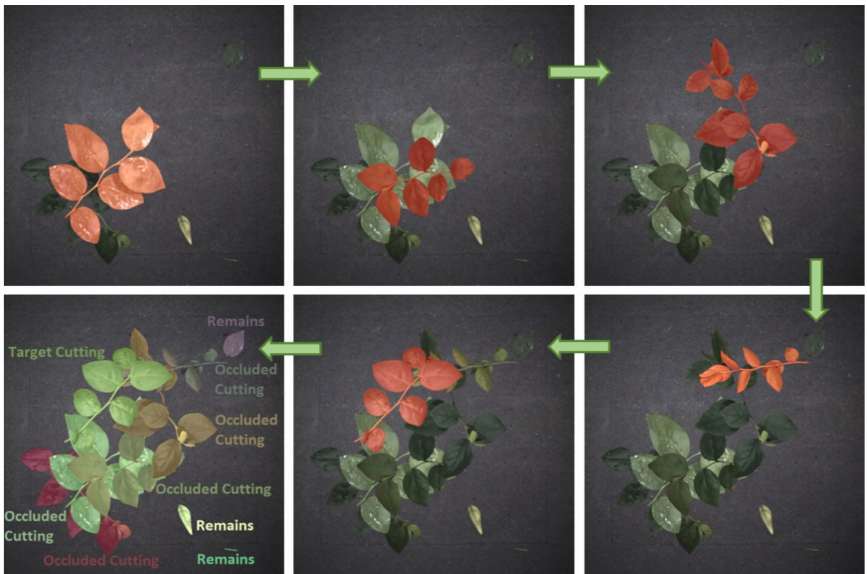
Figure 4. A synthesized image and several intermediate views of the synthesis